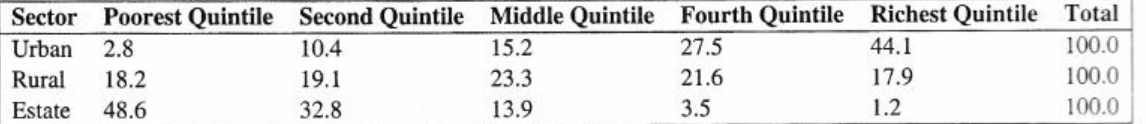
Figure 2 Area graph showing the distribution of households from different socio economic quintiles by geographical